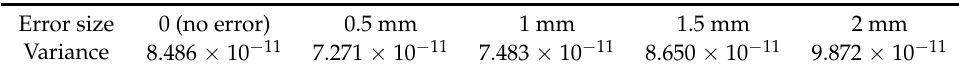
Table 1. Triangle area variance of triangular mesh generated by different measurement